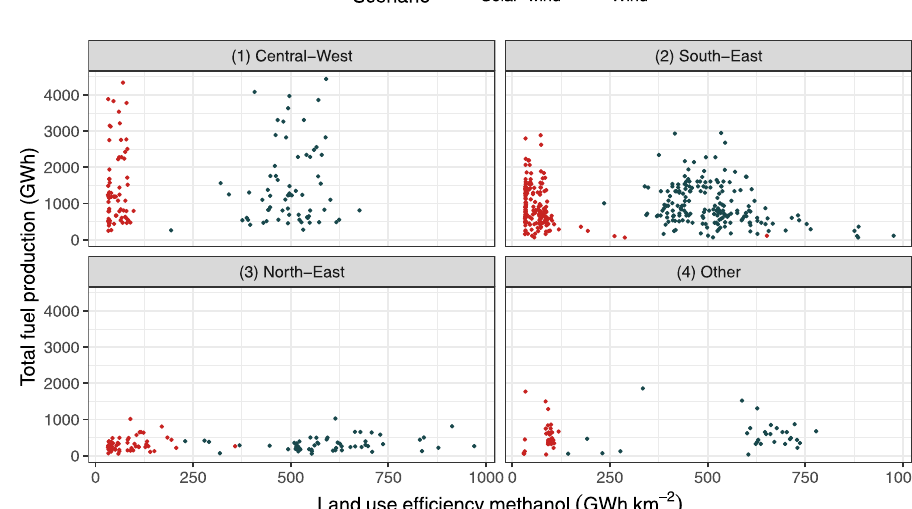
Fig. 2 Land-use ef fi ciency of methanol production versus total fuel production for all Brazilian ethanol facilities in (1) the Central-West, (2) the South- East, (3) the North-East, and (4) other Brazilian regions. The panels show the land-use ef fi ciency of methanol production measured in GWh km − 2 versus the total fuel production in that particular facility. Red points relate to scenarios using both PV and wind power, green points relate to wind power only